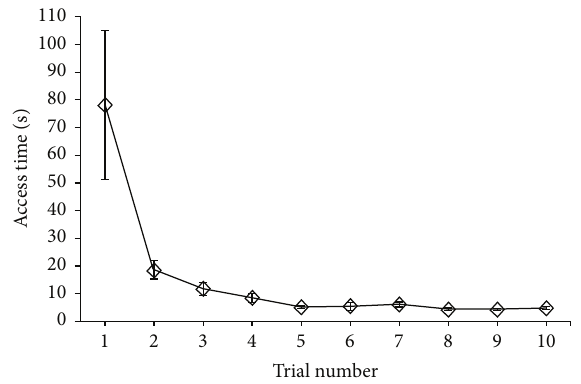
Figure 6: The learning curve (time/sec) ( ± SE) taken to access and forage on syrup for 9 workers of Bombus impatiens which were allowed to contact with their nestmates B1 (i.e., they were watching the experienced bees from colony A). The B2 bees were kept inside the hive and then, after release to forage, had apparently learned to manipulate the artificial flowers through communication with their nestmates. H 0 showing that the durations for successful foraging are independent of experience of having communicated with their nestmates is rejected ( 𝐹 8,9 = 21.4 ; 𝑃 < 0.001